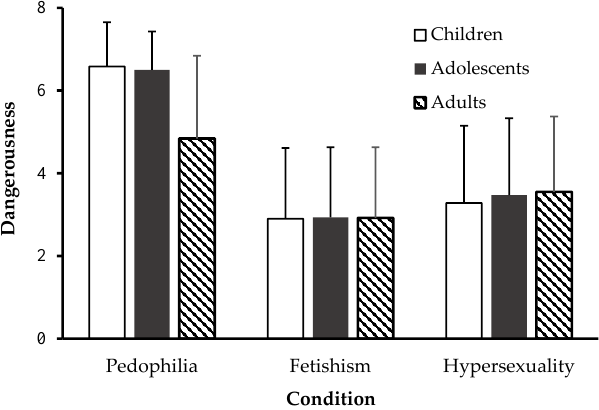
Figure 1. Scores for Pedophilia, Fetishism, and Hypersexuality on Items for Perceived Dangerous- ness for Children, Adolescents, and Adults.